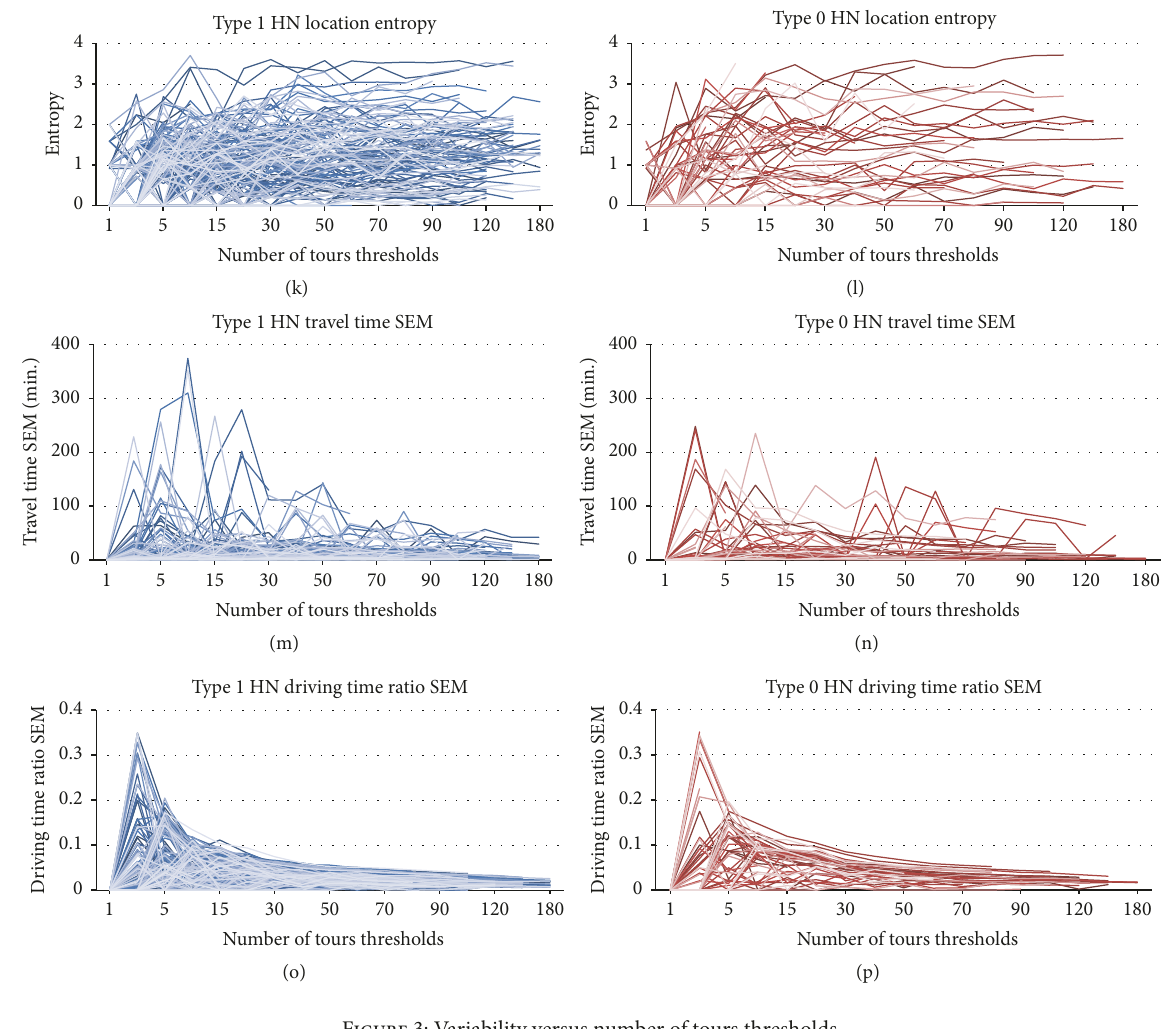
Figure 3: Variability versus number of tours thresholds.